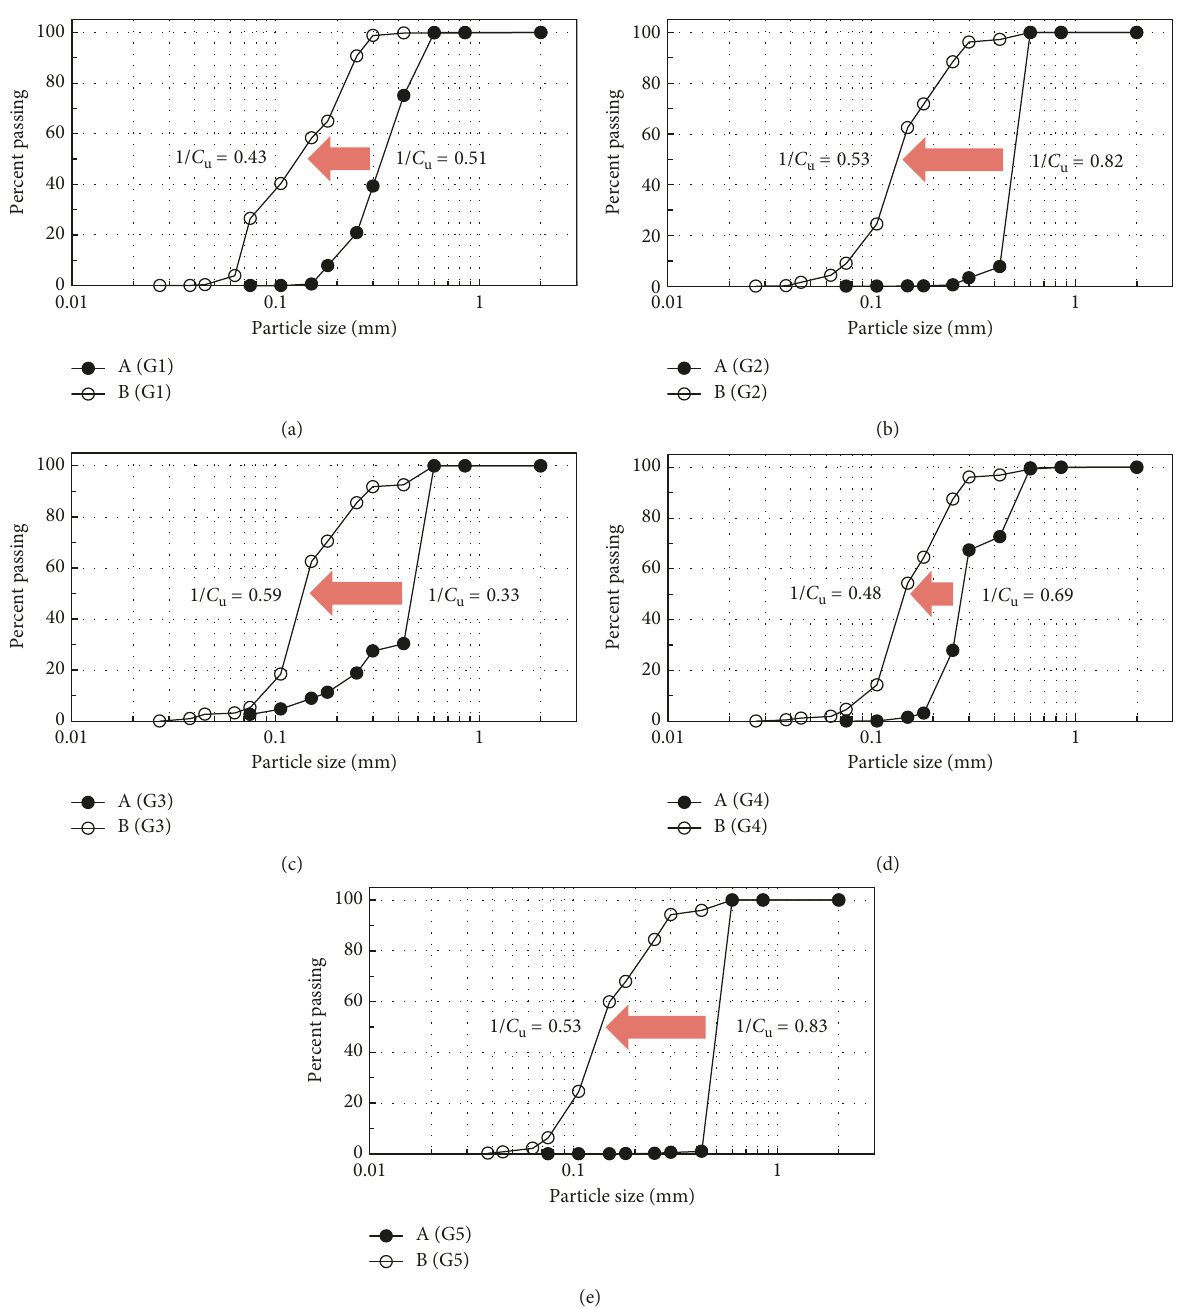
Figure 10: Change of particle size distribution after rock cutting (A: condition before cutting, B: condition after cutting) for the five garnet